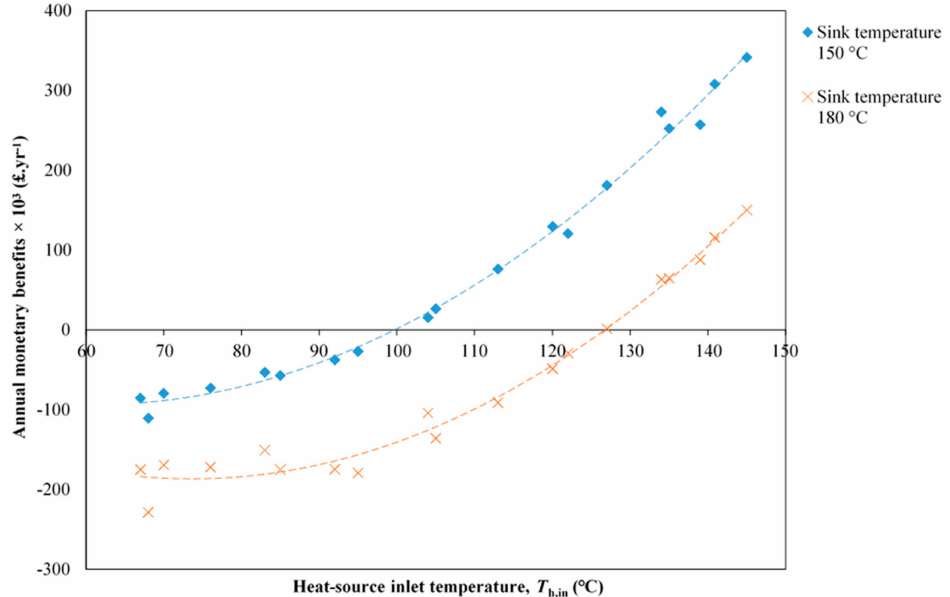
Figure 12. Annual monetary benefits arising from the generation of LP steam (150 ◦ C) and medium pressure (MP) steam (180 ◦ C) with MVC heat pumps as a function of heat-source inlet temperatures which range between 65 and 145 ◦ C when utilizing the thermal energy available in the streams in Table 5. Based on gas / electricity prices in China (Appendix A) as an example